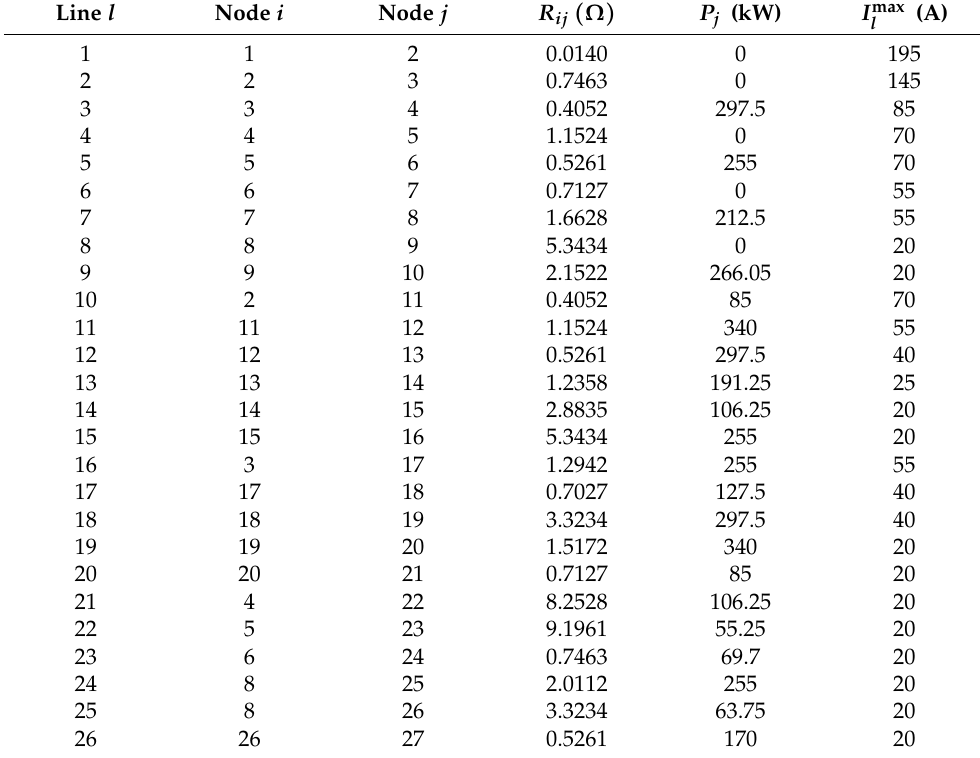
Figure 4. Electrical configuration of the standalone DC network. Table 3. Parametric information of the standalone network.